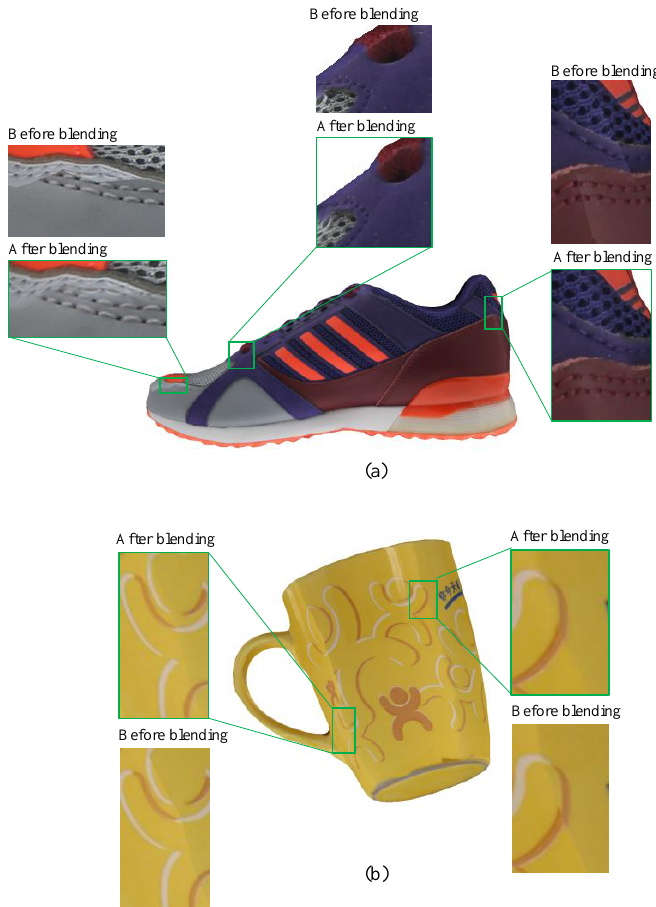
Figure 15. Results before and after the implementation of the proposed blending algorithm: ( a ) shoe and ( b ) cup.